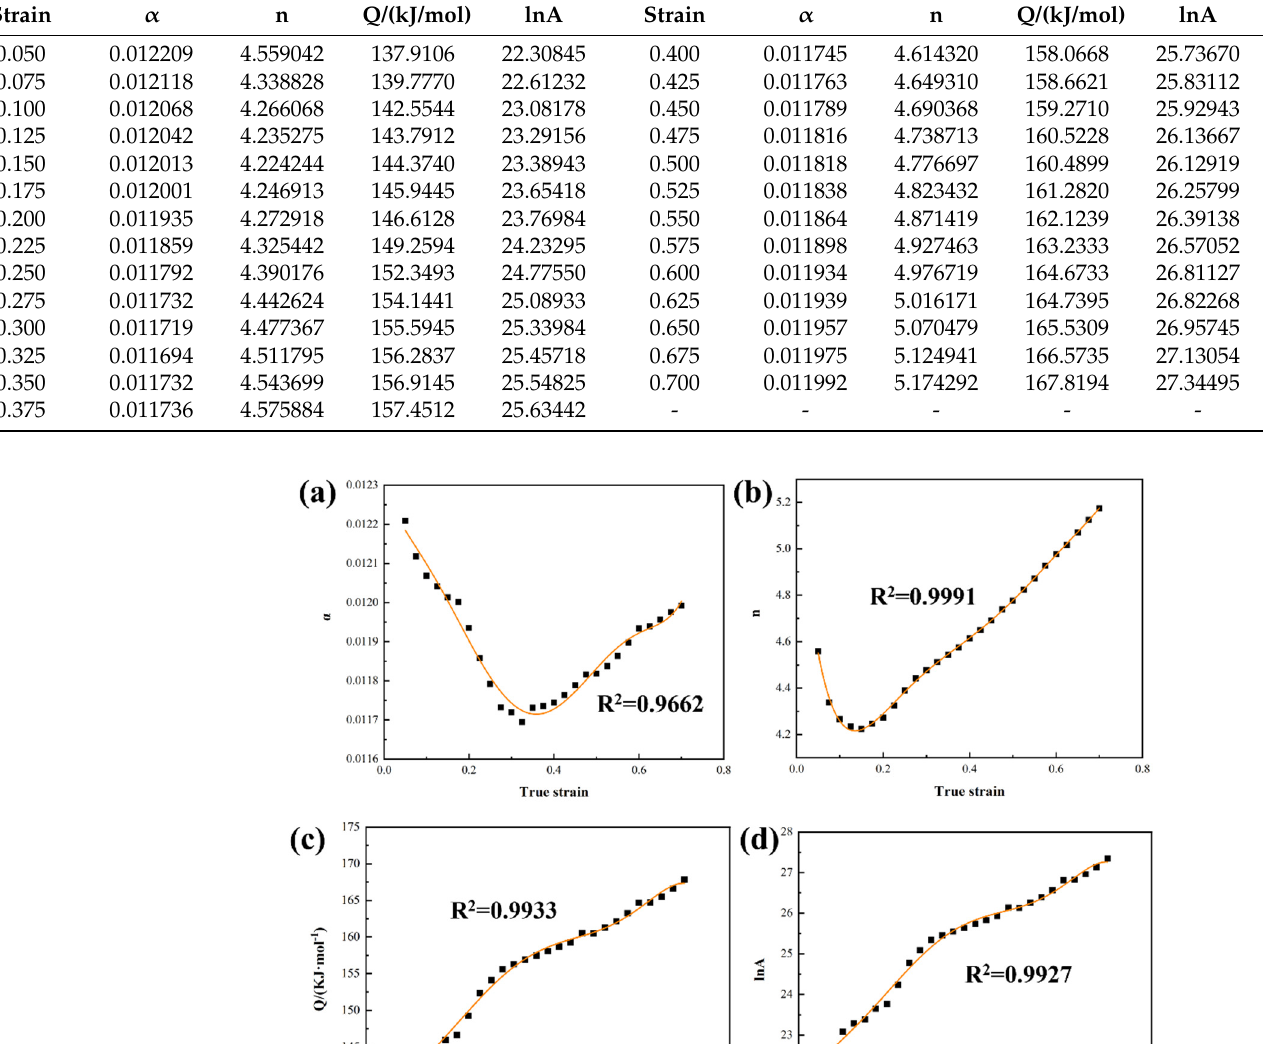
Table 3. Relationship between material constant and true strain.